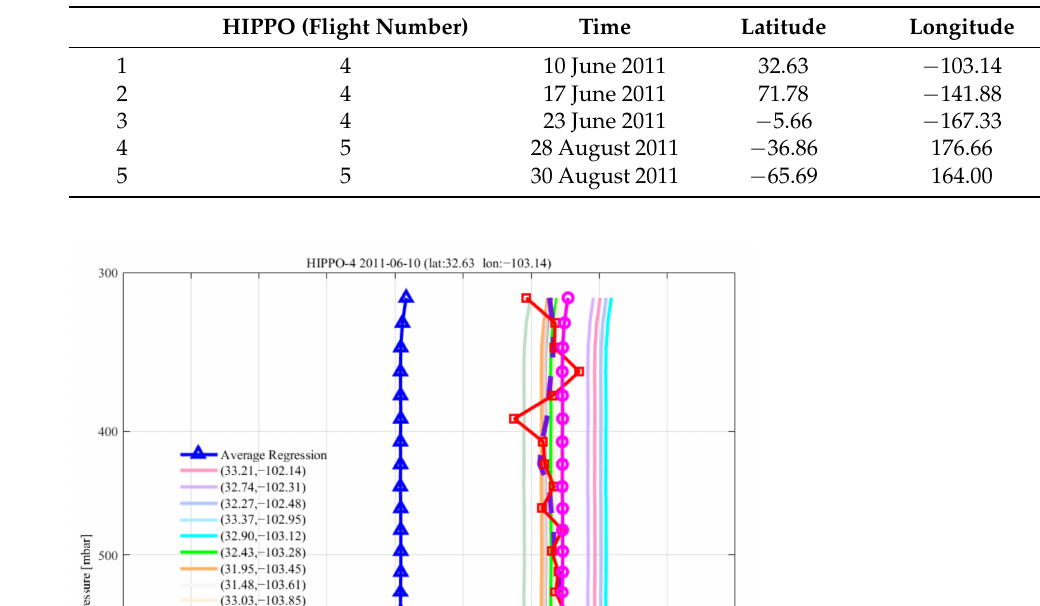
Table 3. HIPPO data selected to validate the algorithms.